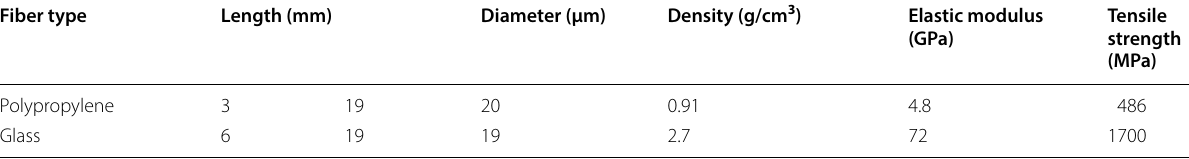
Table 3 Physical properties of PP and glass